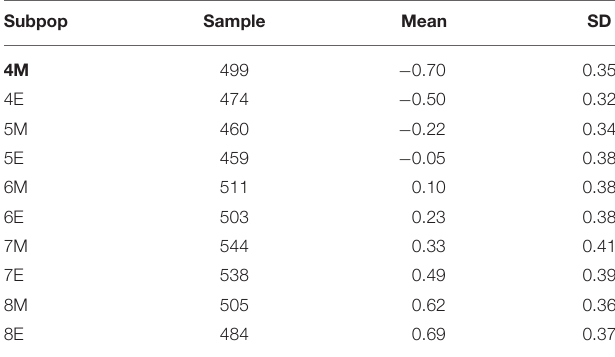
TABLE 2 | Item bank spelling mean and SD in normal distributed